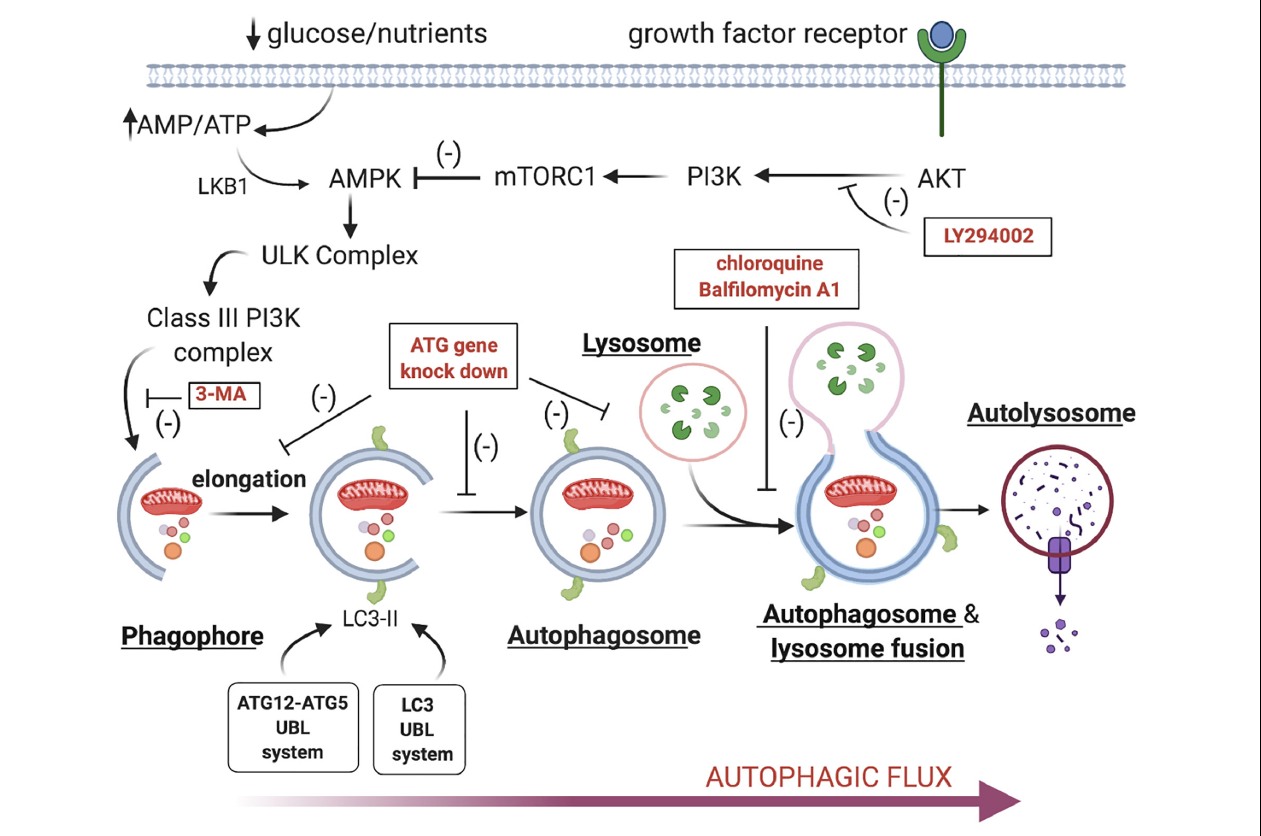
FIGURE 1 | Signal transduction cascade regulating autophagy. Loss of growth factor stimulation or nutritional inputs like glucose lead to the activation of the ULK complex and the subsequent activation of the Class III PI3 Kinase complex. This drives phagophore assembly and the subsequent recruitment of cellular constituents like damaged mitochondria, protein aggregates and bulk cytoplasm. The phagophore elongates and circularizes to form the autophagosome, which then docks with lysosomes. The fusion of these two organelles leads to autolysosome formation and the destruction of the enclosed cargo via lysosomal hydrolases. [It should be noted that this is distinct from lysosome-mediated cell death in which lysosome rupture and release degradative enzymes like cathepsins (reviewed in Wang et al., 2018)]. Several inhibitors or genetic interventions are available that can block autophagy at key regulatory points (labeled red in boxes) (Vakifahmetoglu-Norberg et al.,